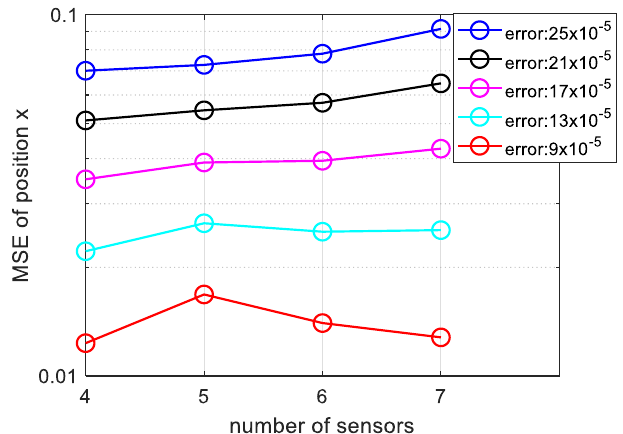
Figure 11. Variation of MSE of position x versus the number of sensors and varying measurement noise under bellhop underwater channel model.